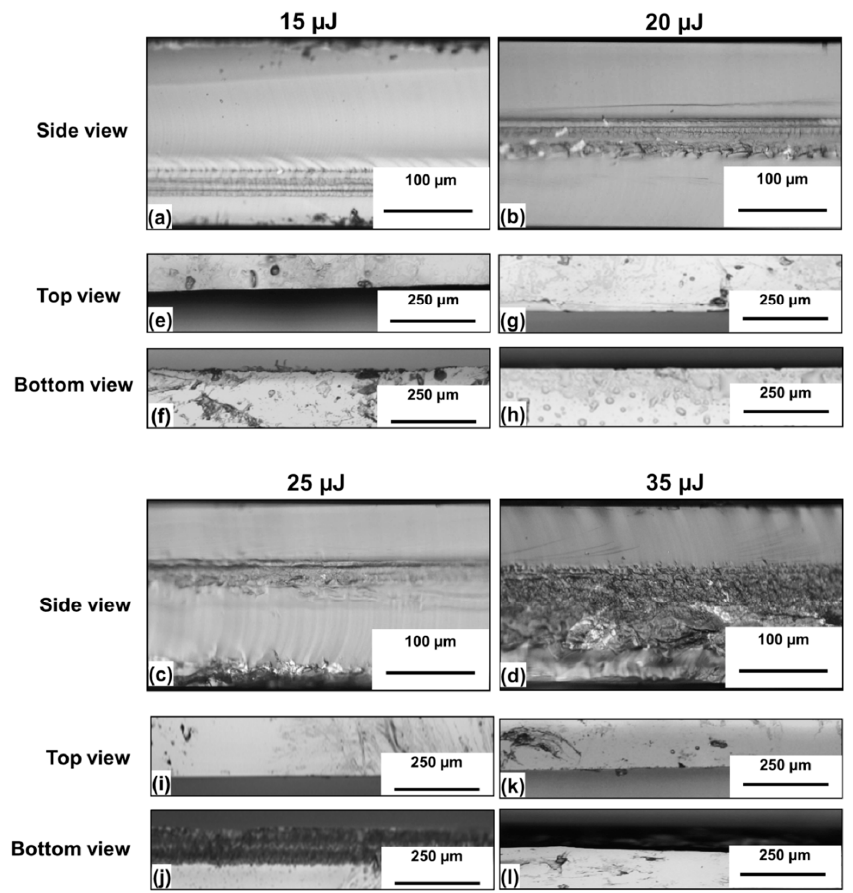
Figure 4. ( a – d ) Side view of the cut edges obtained at 50 kHz, at the scan speed of 1 mm/s and four different pulse energies. The top (( e ), ( g ), ( i ), ( k )) and the bottom (( f ), ( h ), ( j ), ( l )) views are also